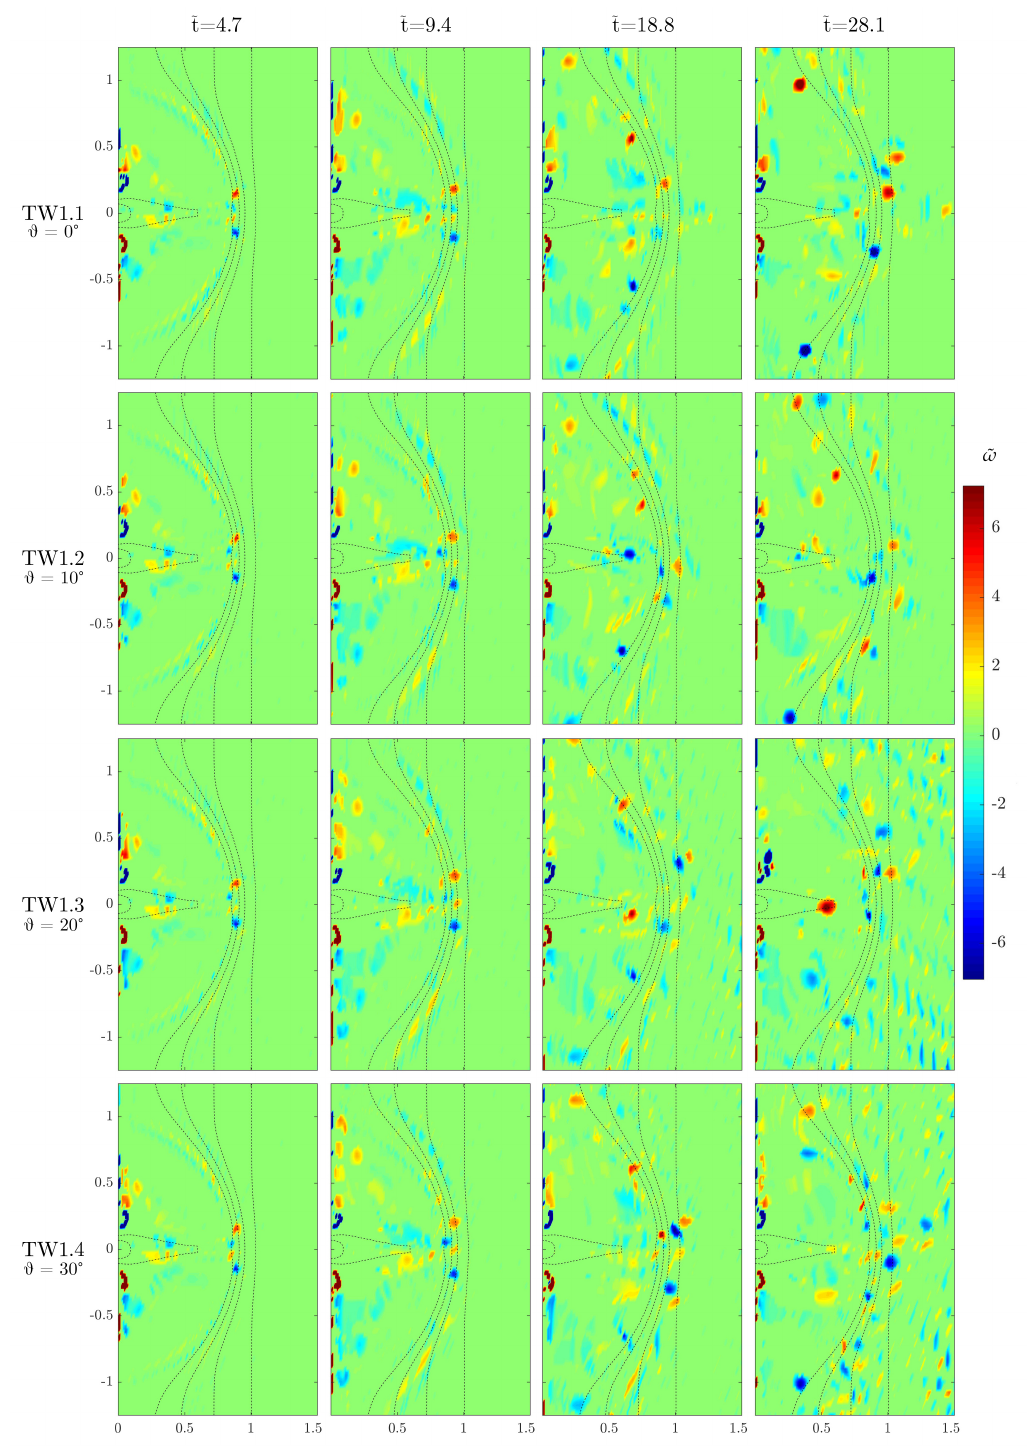
Figure 10. Time evolution of vorticity for test TW1 as a function of wave direction. Each row represents a different wave direction (from top to bottom: θ = 0 ◦ , 10 ◦ , 20 ◦ , and 30 ◦ ). Each column represents a single time level (from left to right: ˜ t = 4.7, 9.4, 18.8, and 28.1). Red tones represent clockwise vorticity; blue tones represent anticlockwise vorticity. The dotted lines show the bathymetry contours of the shoal edge and the main